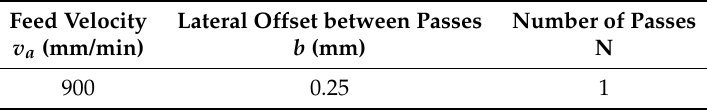
Table 3. Parameters kept constant during the experimental